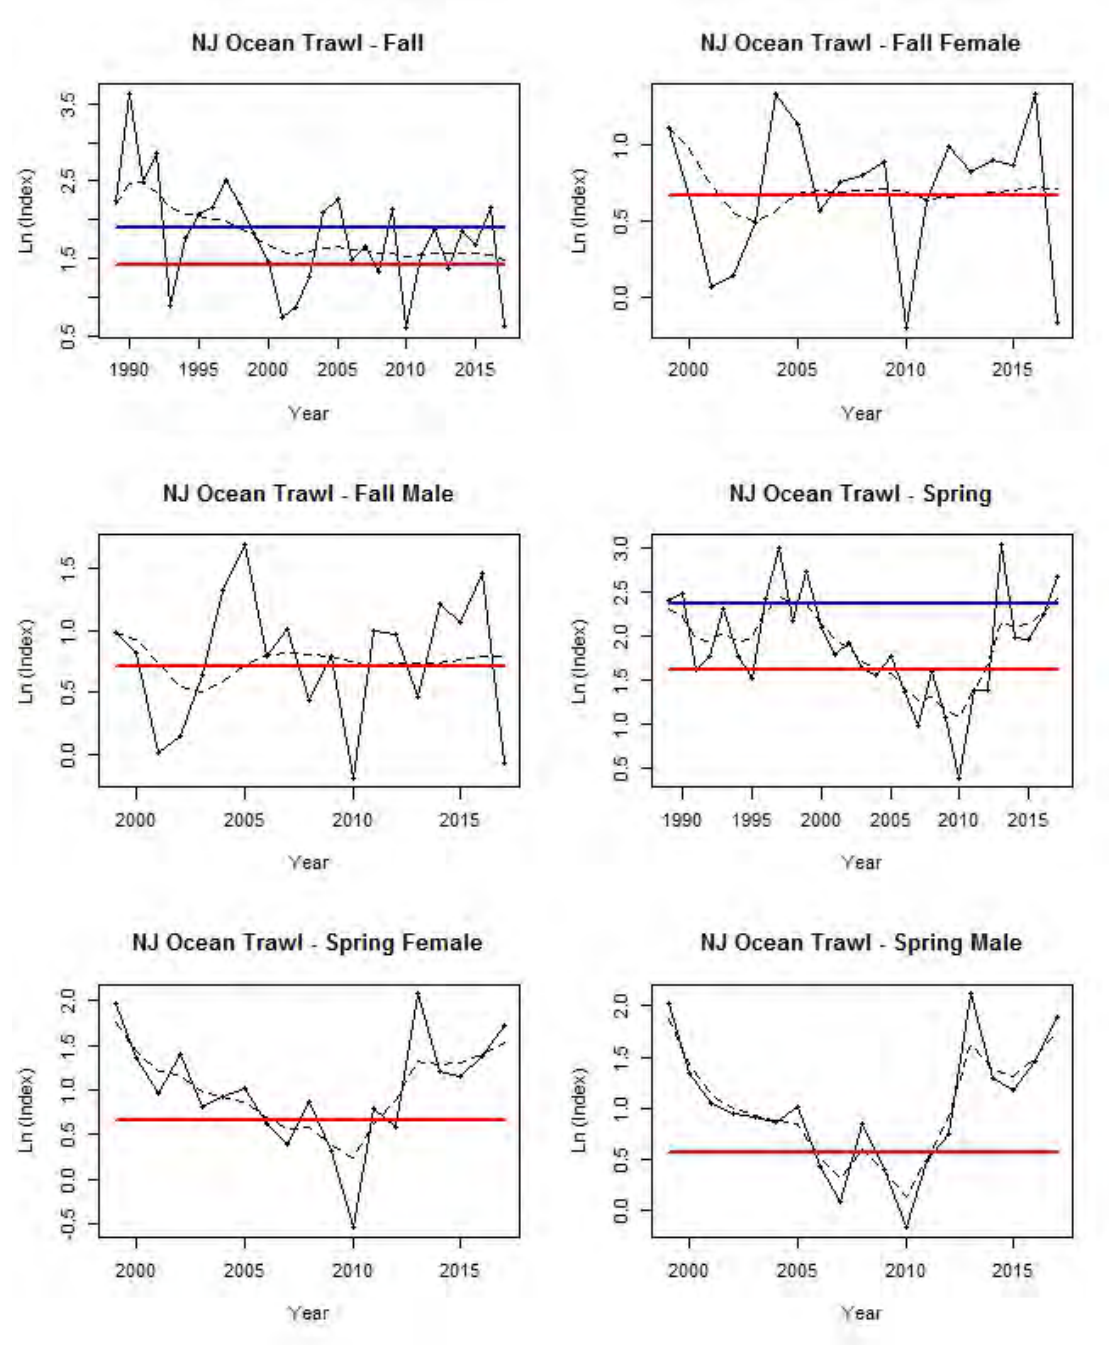
Figure 87. ARIMA model fits to horseshoe crab indices from the NJ Ocean Trawl survey in the Mid-Atlantic Region. The solid line represents the observed ln transformed indices and the dashed line represents the fitted indices. The red horizontal line represents the Q 25 reference point and the blue horizontal line represents the 1998 reference